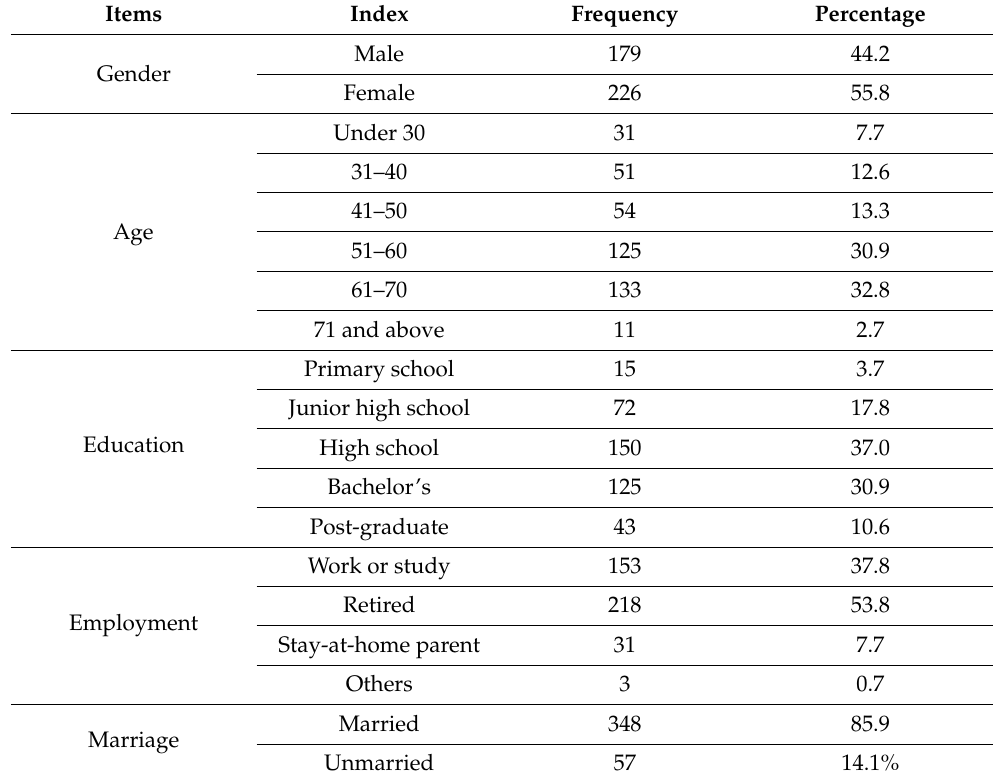
Table 1. Demographic characteristics of survey